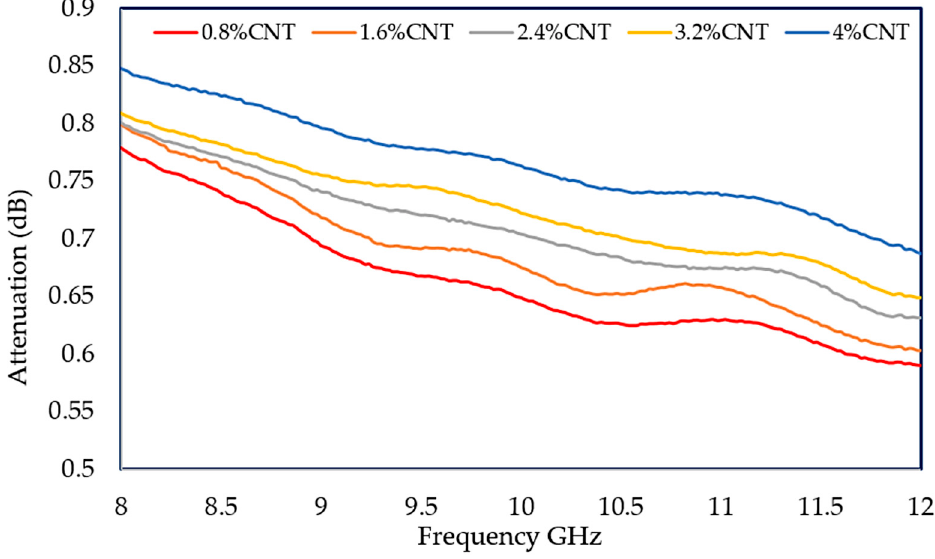
Figure 14. Electromagnetic waves attenuation in the MWCNT / PLA / PEG nanocomposites at X-band frequency.